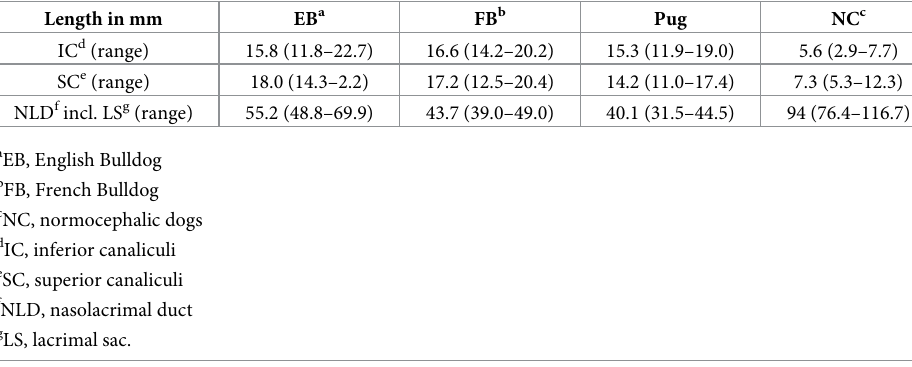
Table 3. Lengths of the NLD and the inferior and superior lacrimal canaliculi (median values). The mean length of the NLD including the lacrimal sac is 55.2 mm in English Bulldogs, 43.7 mm in French Bulldogs, 40.1 mm in Pugs, and 94.0 mm in the normocephalic control